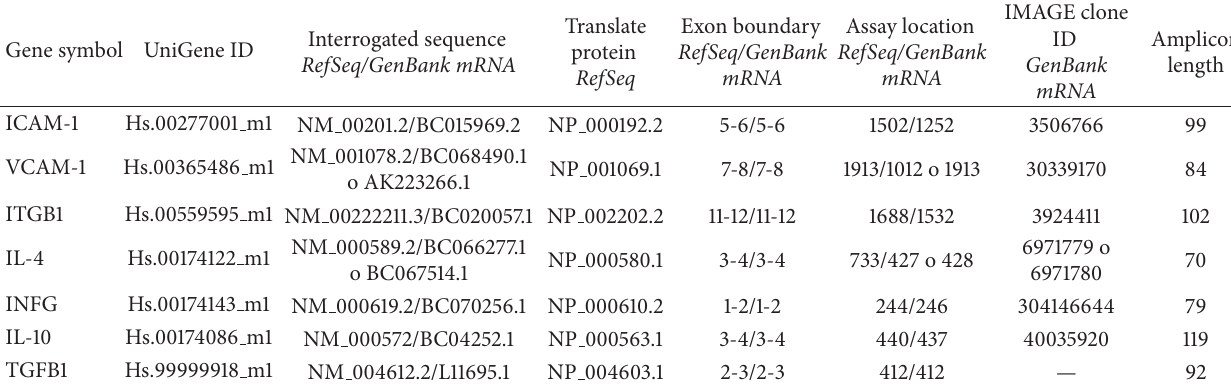
Table 2: Real-time PCR